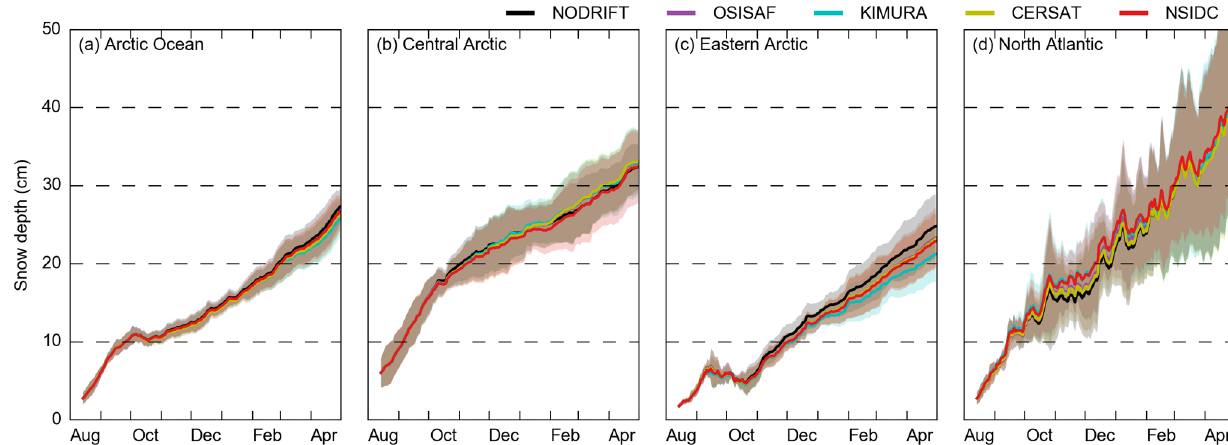
Figure 11. Seasonal snow depth evolution across the four study regions (shown in Fig. 5), initiated on 15 August 2010, 2012, 2013 and 2014, and run until 1 May of the following year, forced by four different ice motion datasets and assuming no ice motion (NODRIFT). The thick lines show the mean (daily) regional snow depths over this time period, while the shaded areas represent interannual variability (1 standard deviation). All model runs use the default/MEDIAN-SF parameter settings.